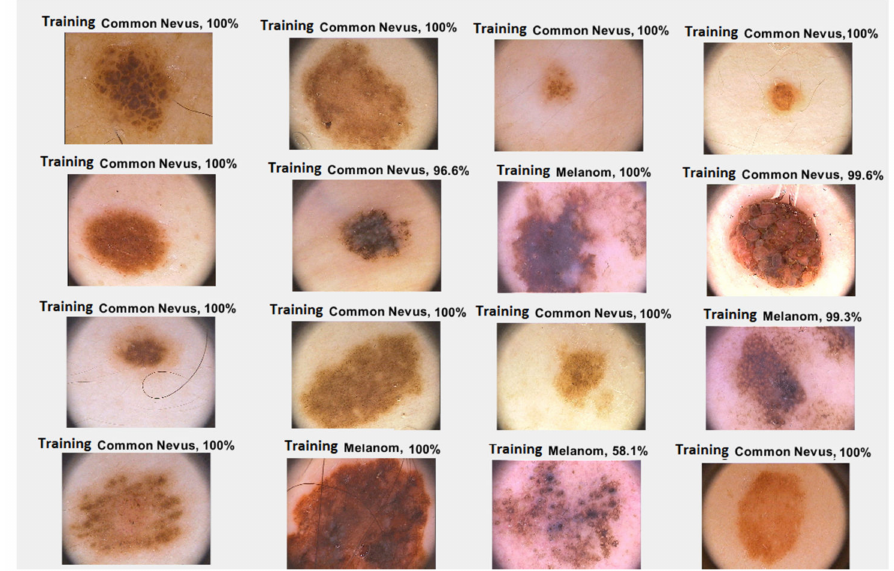
Figure 17. Validation images with predicted labels and predicted probabilities in case of GoogleNet.